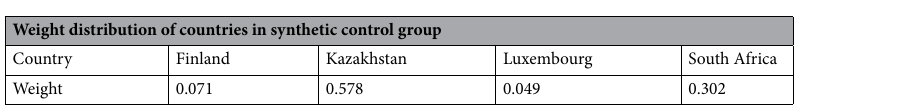
Figure 1. energy consumption per unit of GDP estimated by SCM. Weight distribution of countries in synthetic control group